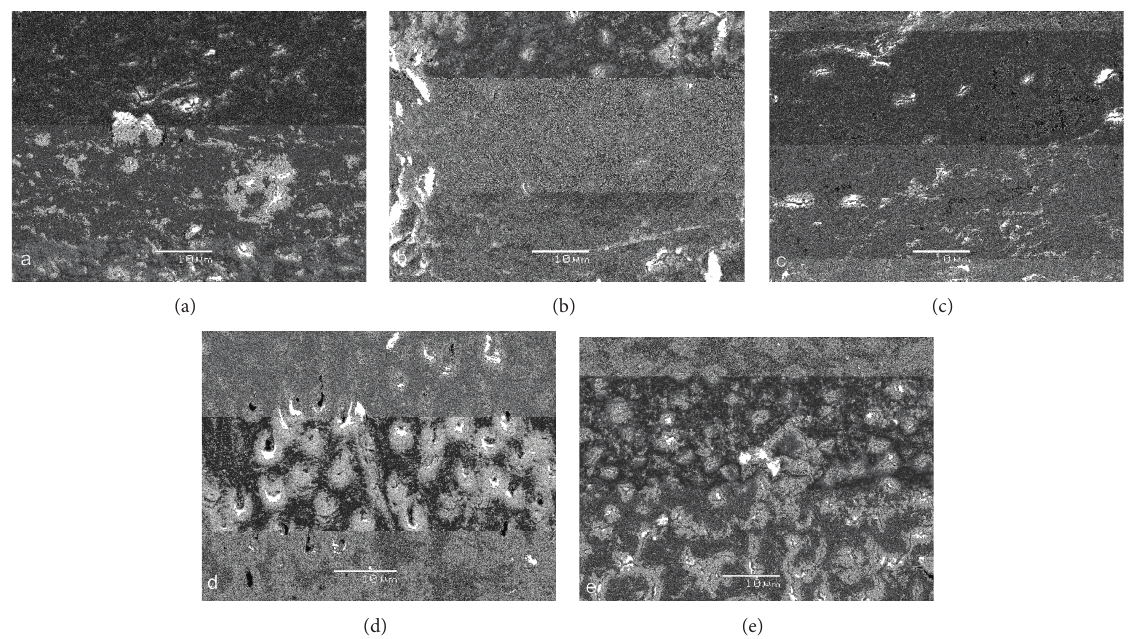
Figure 6: Photomicrographs of root canal wall in each group after final cleaning protocols (original magnification: 2000x; scalebar is 10 𝜇 m). Images (a)–(e) show canal walls at 1, 3, 6, 8, and 12mm from the apex. A dense and heterogeneous smear layer covering the entire dentinal wall was observed in groups 5 and 10. (a) is at 1mm from the apex, and (e) is at 12mm from the